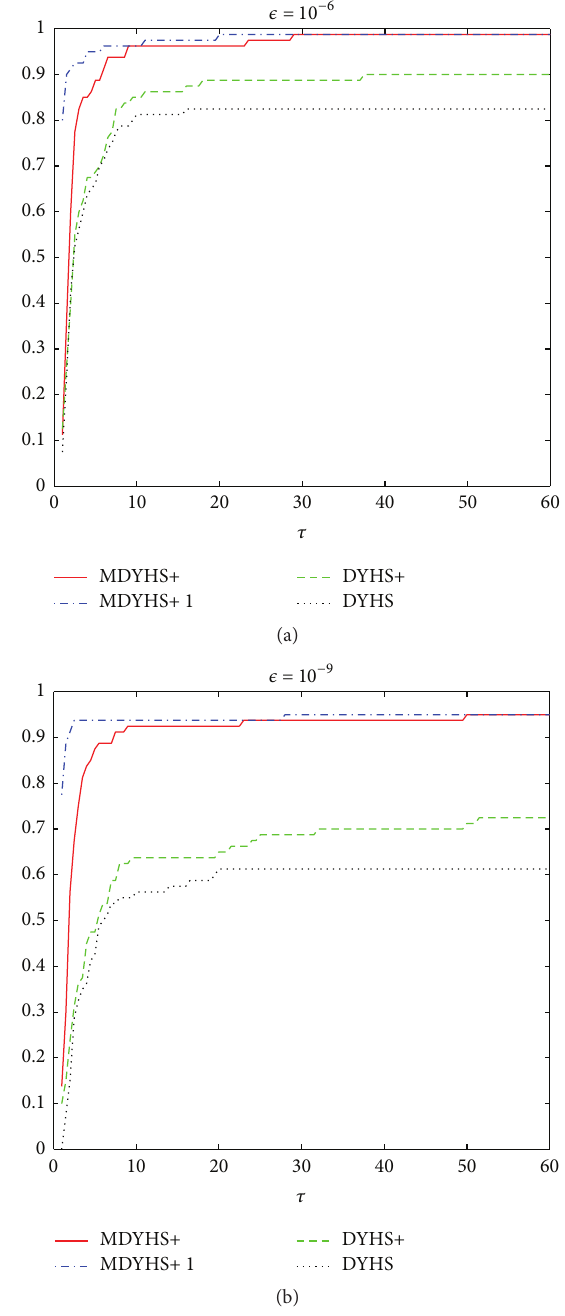
Figure 1: Performance profiles based on CPU